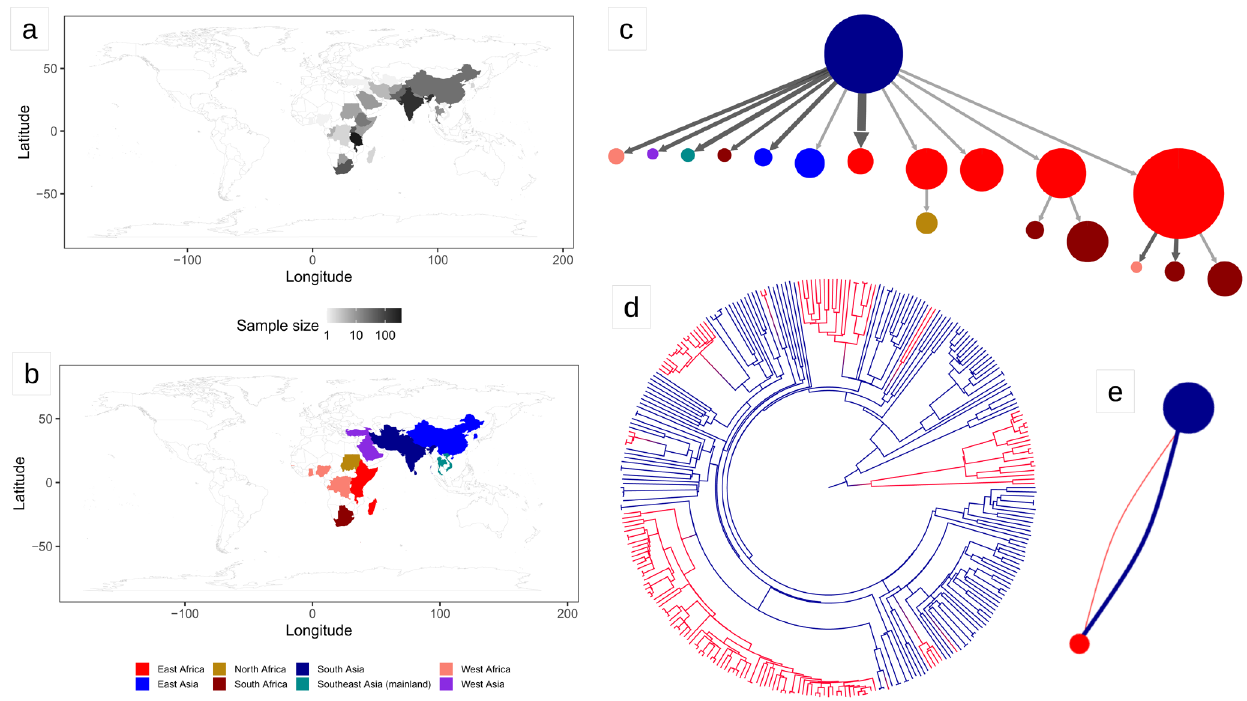
Figure 2. Results of the biogeography analysis: L3. a) Heatmap indicating the origin of 1,021 L3 strains included in the dataset used for the biogeography analysis. b) The geographic regions used in the biogeography analysis of L3. c) Results of PASTML (compressed tree), the color code follows the legend of panel ( b ), the size of the circles is proportional to the number of tips, and the size of the arrows is proportional to the number of times the pattern of migration was observed on the tree. This plot excluded nodes that represent less than three strains, the same plot including all nodes can be found as Extended Data File 3. d) Tree obtained with the Mascot analysis; the branches are colored following the legend in panel ( b ) and represent the inferred ancestral region with the largest posterior probability. e) Representation of the relative effective population sizes (circles) and migration rates (lines connecting circles) estimated by Mascot. Lines representing migration rates are colored based on the region of origin (interpreted forward in time). The effective population size of South Asia was estimated to be much larger than the one of East Africa. Additionally, the forward migration rate between South Asia and East Africa was much larger than the one in the opposite direction. The parameter estimates are reported in Extended Data Table